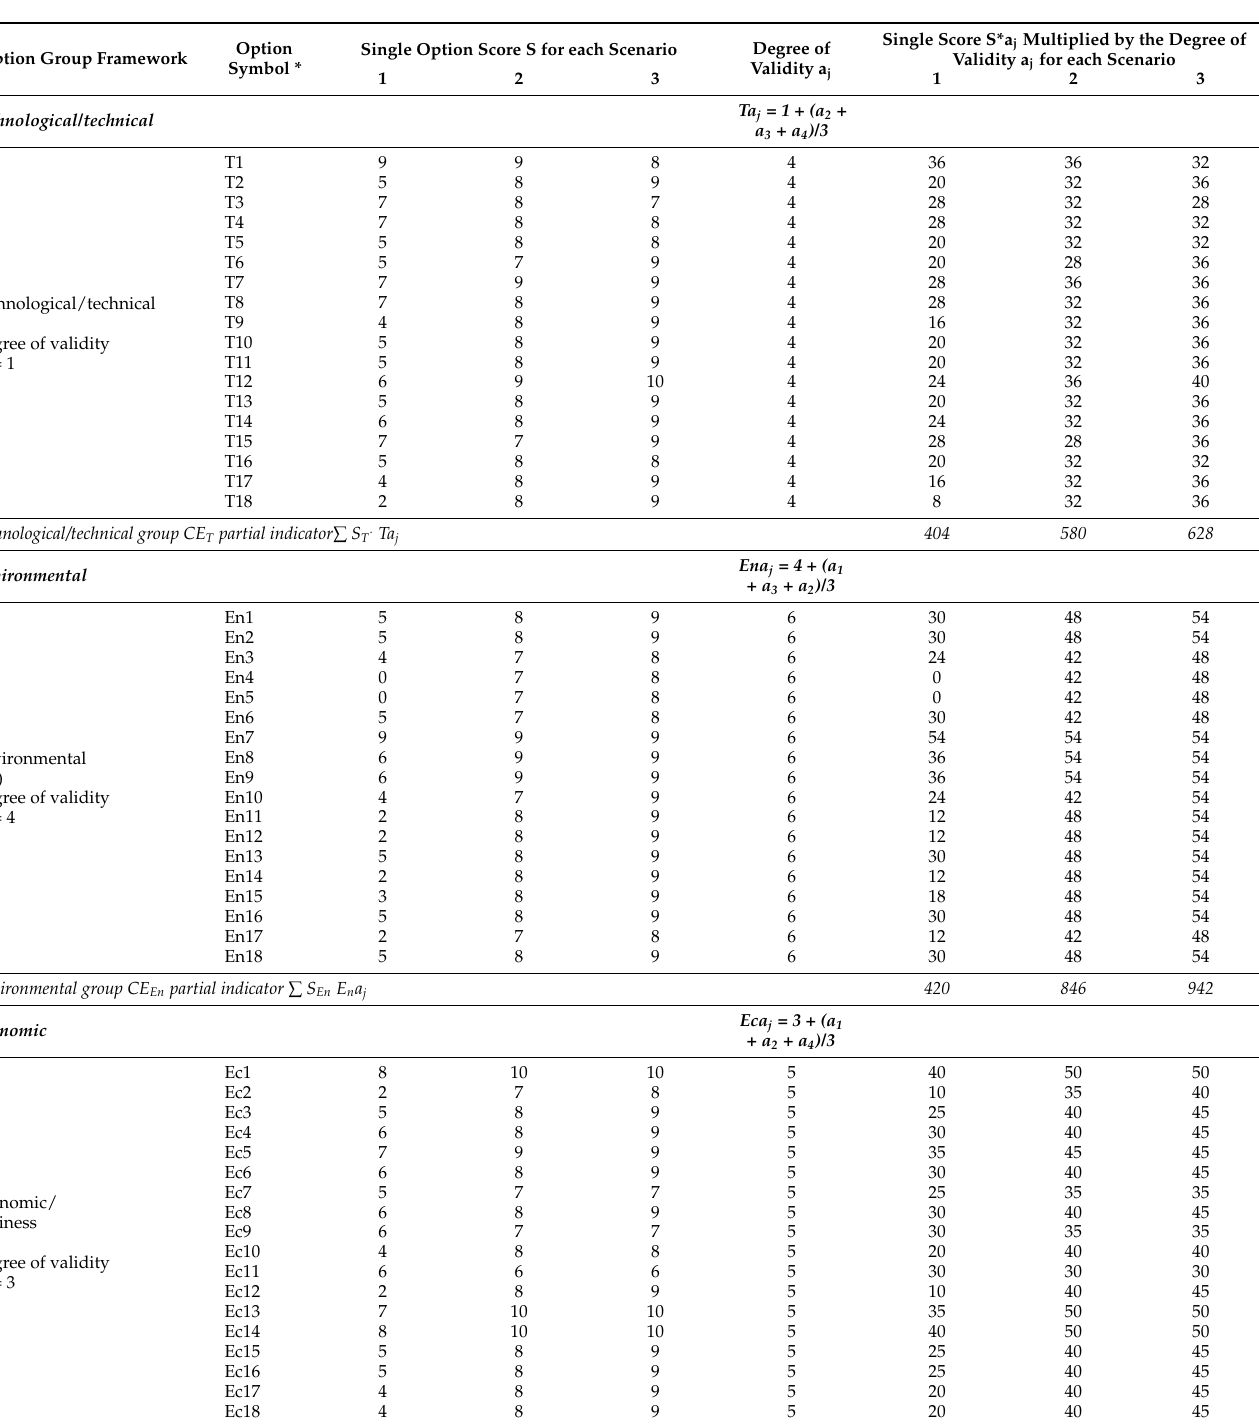
Table 4. Assessment of CE micro-level indicators for the comparison of municipal waste management systems: Scenario 1—Incineration; Scenario 2—Renasci Smart Chain Process; Scenario 3—BioRen- Renasci